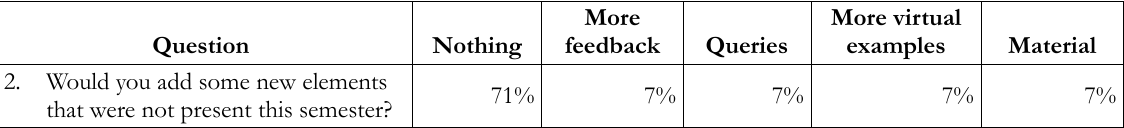
Table 12. Responses to the second open question of the student satisfaction questionnaire